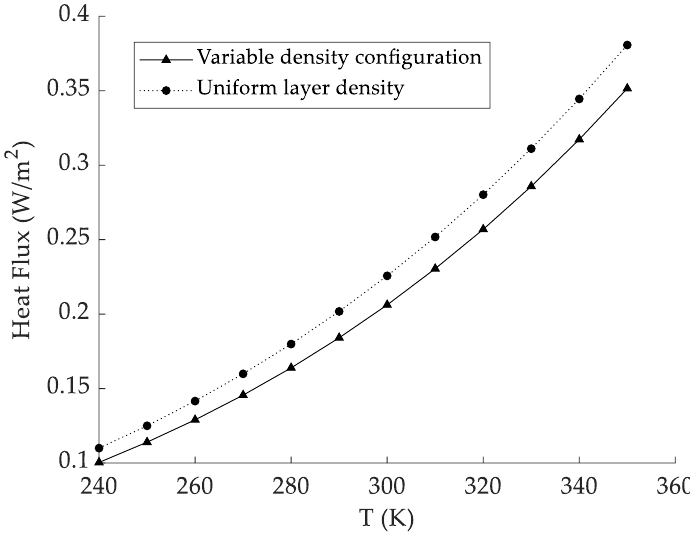
Figure 14. Comparison of the heat flux between variable density configurations and the uniform layer density.